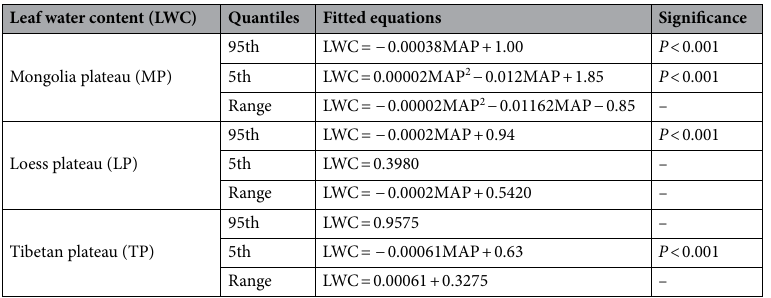
Table 2. Boundary analyses and significance tests for the spatial variation of leaf water content. † 95th and 5th represented 95% upper boundary and 5% lower boundary. Range is the fluctuation to leaf water content (LWC) between the upper and lower